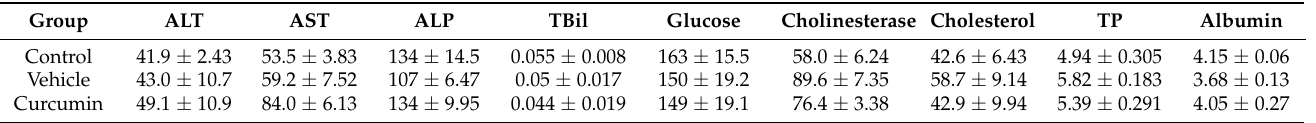
Table 2. Biochemical serum values for alanine transaminase (ALT), aspartate transaminase (AST), alkaline phosphatase (ALP), total bilirubin (TBil), glucose, cholinesterase, cholesterol, total protein (TP), and albumin. Levels are expressed in international units of activity per liter (IU/L) for ALT, AST, ALP, and cholinesterase; in milligrams per deciliter (mg/dL) for TBil, glucose, and cholesterol; and in grams per deciliter (g/dL) for TP and albumin. Group ALT AST ALP TBil Glucose Cholinesterase Cholesterol TP Albumin Control 41.9 ±